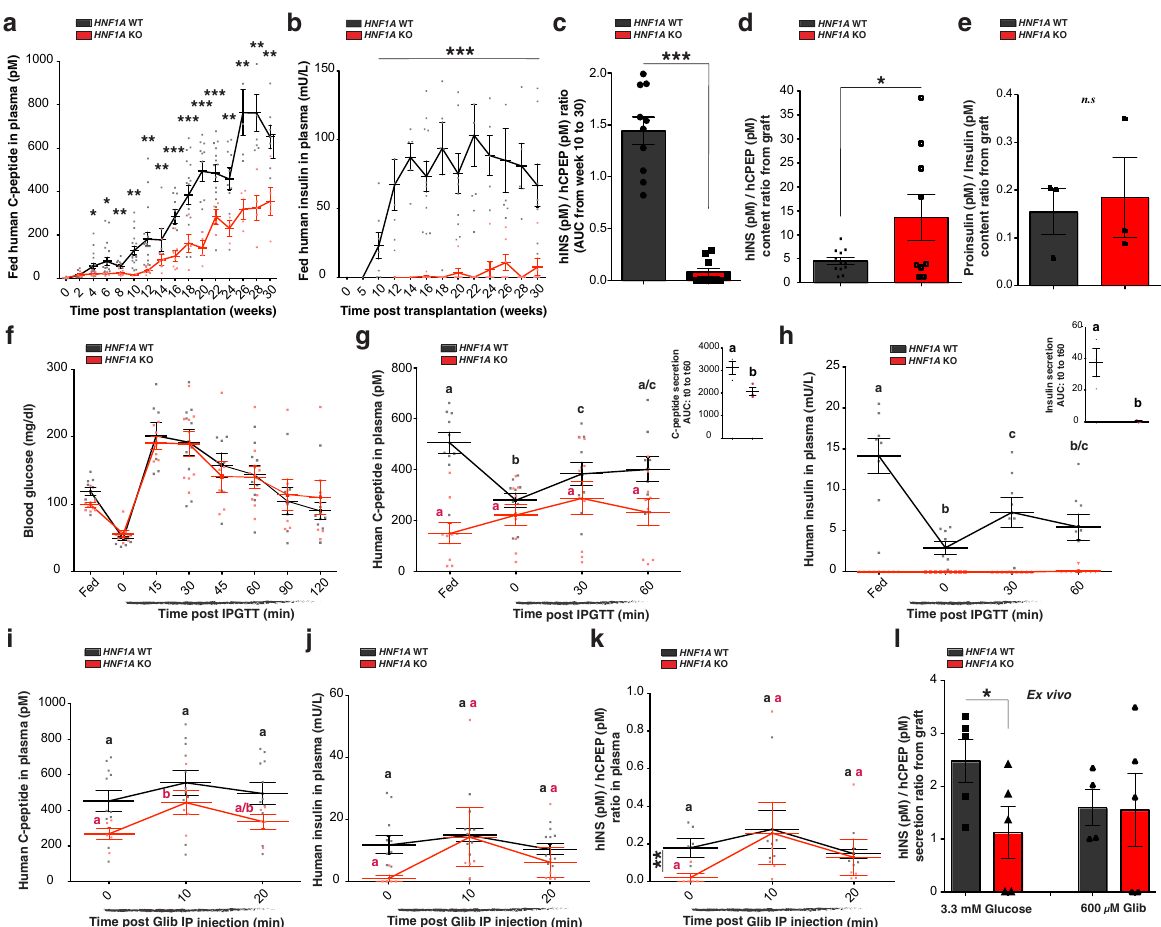
Fig. 4 HNF1A de fi ciency alters the stoichiometry of insulin to C-peptide secretion in vivo. a Plasma human C-peptide (pM) and b human insulin secretion (mU/L) in plasma of ad libitum - fed mice transplanted with hESC-derived endocrine cells ( HNF1A WT n = 18 and KO n = 7). c hINS(pM)/ hCPEP(pM) ratios are displayed as the area under the curve (AUC) from week 10 to week 30 post-transplantation. d , e Content ratio from isolated grafts: d hINS(pM)/hCPEP(pM) content ratio and e Proinsulin(pM)/Insulin(pM) content ratio. f – h IPGTT in mice transplanted with hESC-derived endocrine cells ( HNF1A WT n = 10 and KO n = 8) in ad libitum - fed state and during an iPGTT (t0, t30 and t60). f Blood glucose concentrations (mg/dl), g human C-peptide (pM), and h human insulin secretion (mU/L) in plasma. AUC: area under the curve from t0 to t60. p -values were b : p < 0.001, c : p < 0.05, a , c : p < 0.05 and b , c : p < 0.01; two-tailed t -test. i – k Glibenclamide injection in ad libitum - fed mice transplanted with hESC-derived endocrine cells ( HNF1A WT n = 6 and KO n = 5). i Human C-peptide secretion (pM), j human insulin secretion (mU/L), and k hINS (pM)/hCPEP (pM) secretion ratios. p - values were b : p < 0.05. l hINS(pM)/hCPEP(pM) secretion ratios ex vivo in response to indicated secretagogues. All mice were transplanted with clusters of hESC- derived endocrine cells at day 27 of differentiation, and grafts were isolated 30 weeks post-transplantation for ex vivo analysis. All protein concentrations were measured by ELISA. n represents the number of biological replicates. For scatter plots, each point in the plot represents an independent biological experiment ( n ). Data are represented as mean ± SEM. Different letters designate signi fi cant differences within the group. p -values: * p < 0.05, ** p < 0.01, *** p < 0.001; two-tailed t -test. n.s. non-signi fi cant. See also Fig.